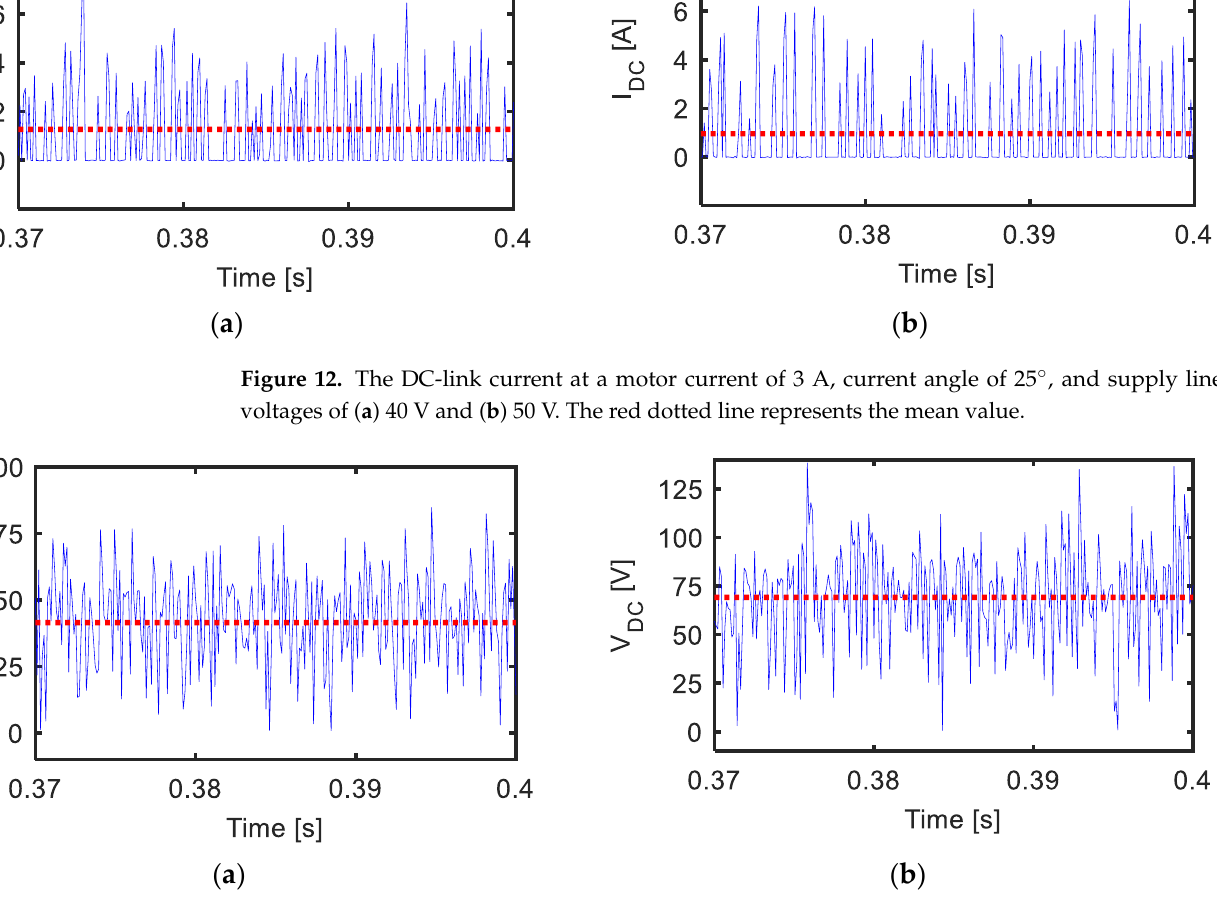
Figure 13. The DC-link voltage at a motor current of 3 A, current angle of 25°, and supply line voltages of ( a ) 40 V and ( b ) 50 V. The red dotted line represents the mean value.